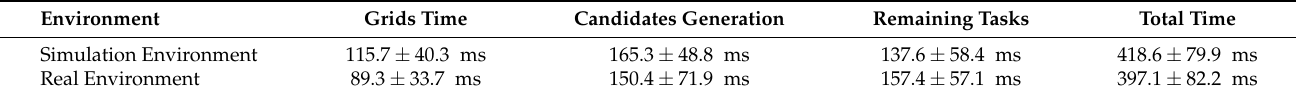
Table 8. Computing-time analysis for the experiments performed in simulation and real environments.